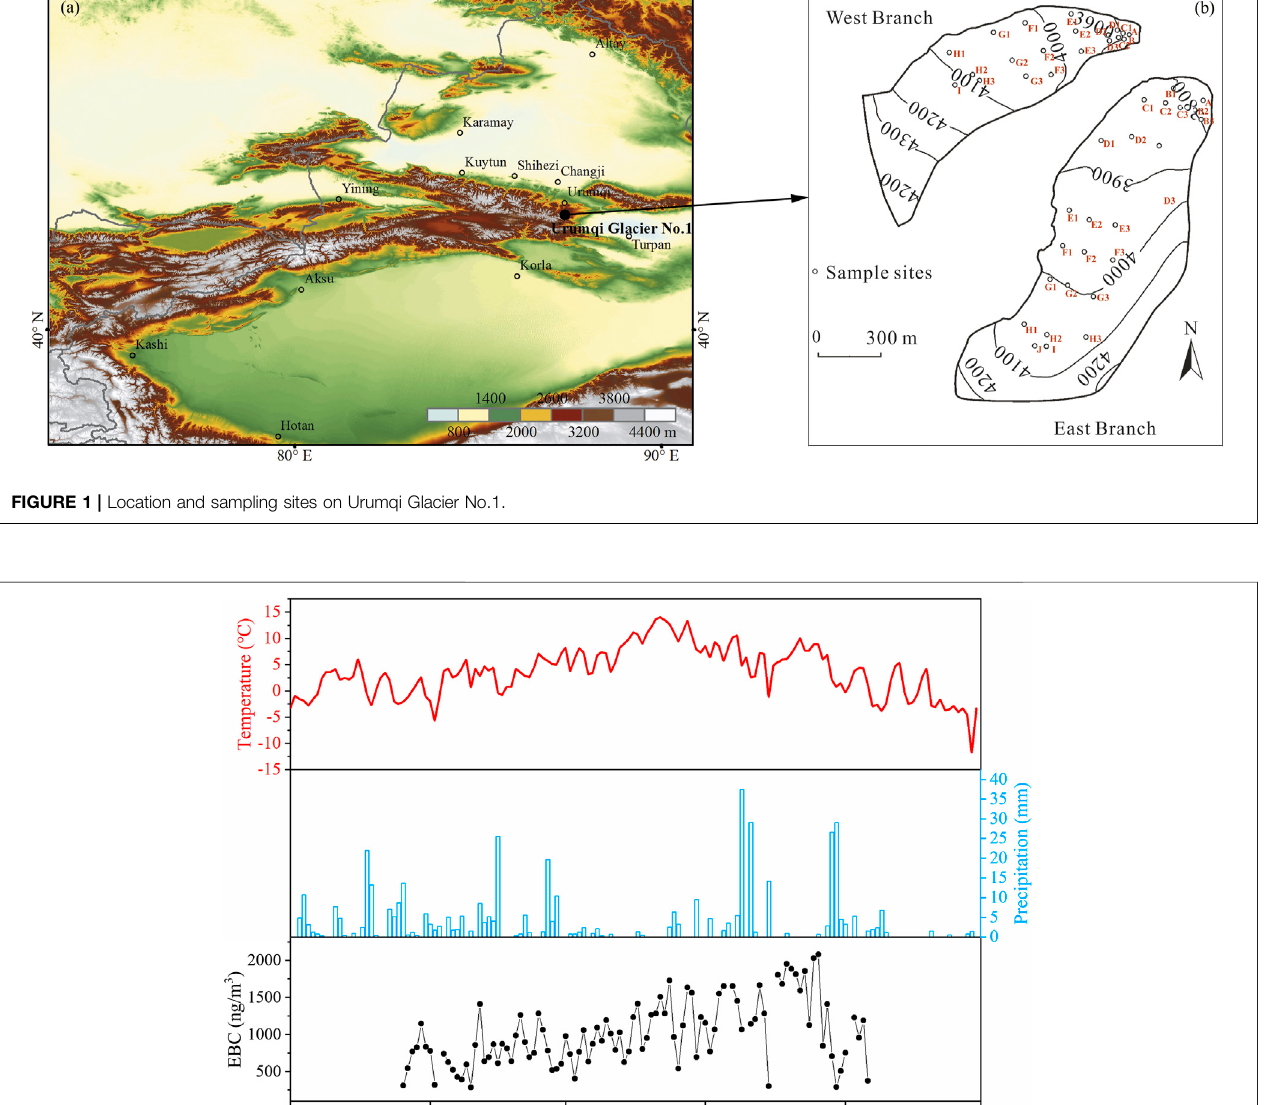
Frontiers in Earth Science |